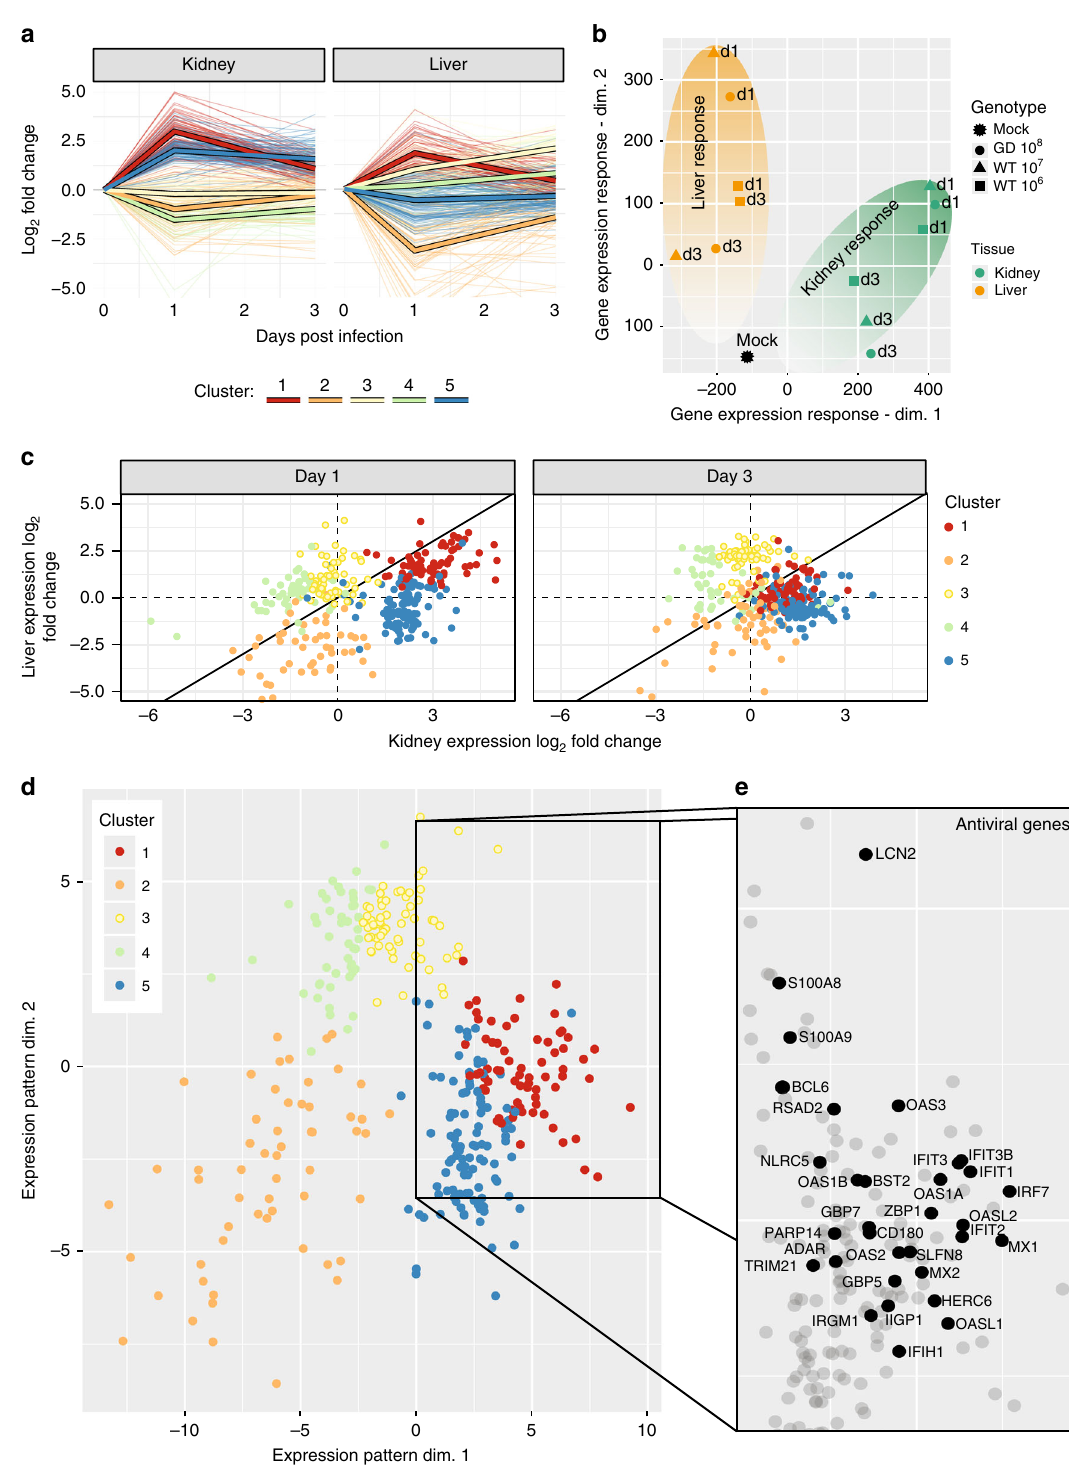
Fig. 3 Tissue-speci fi c transcriptional responses induced by poliovirus infection. a Line plot showing the gene expression pro fi les for 341 genes in liver and kidney from Tg21 mice infected with WT poliovirus at 10 7 PFU by I.P. inoculation route. ( n = 3, the number of mice is three for each time point and each group). Gene expression pro fi les across all experimental conditions were clustered to yield 5 clusters (Methods). Each gene ’ s trajectory is shaded by its cluster and the mean trajectory for each cluster is shown as a thick line. b Multidimensional scaling plot of the transcriptional response trajectories in liver and kidney. Each point represents the mean transcriptional response of three mice. Shaded ovals are drawn to emphasize the distinct trajectories of liver and kidney responses in infected mice. c Scatter plot showing the relative induction of genes in liver and kidney at 1 (left) and 3 (right) days postinfection. Genes are colored by cluster. d A multidimensional scaling plot of the coregulatory relationships between genes. Genes are arranged by the similarity of their expression response (determined by Euclidian distance) and colored by cluster. e Known innate immune and antiviral genes group together in